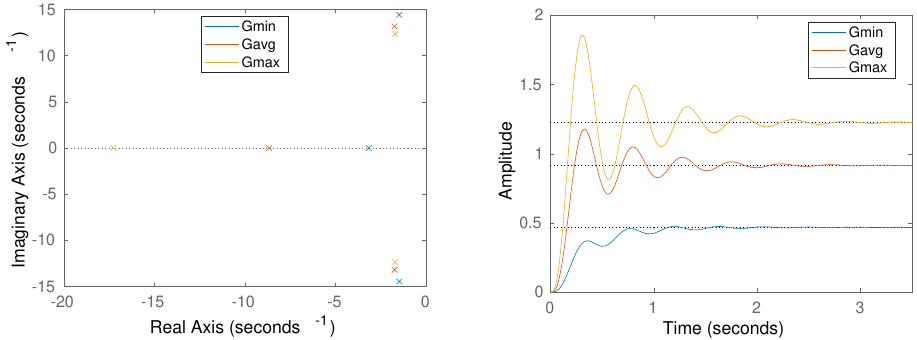
Figure 6. Zero-pole representation ( left ) and unit input time response ( right ) for the three most representative models obtained: Lowest Gain ( G min ), Average Gain ( G avg ) and Maximum Gain ( G max )